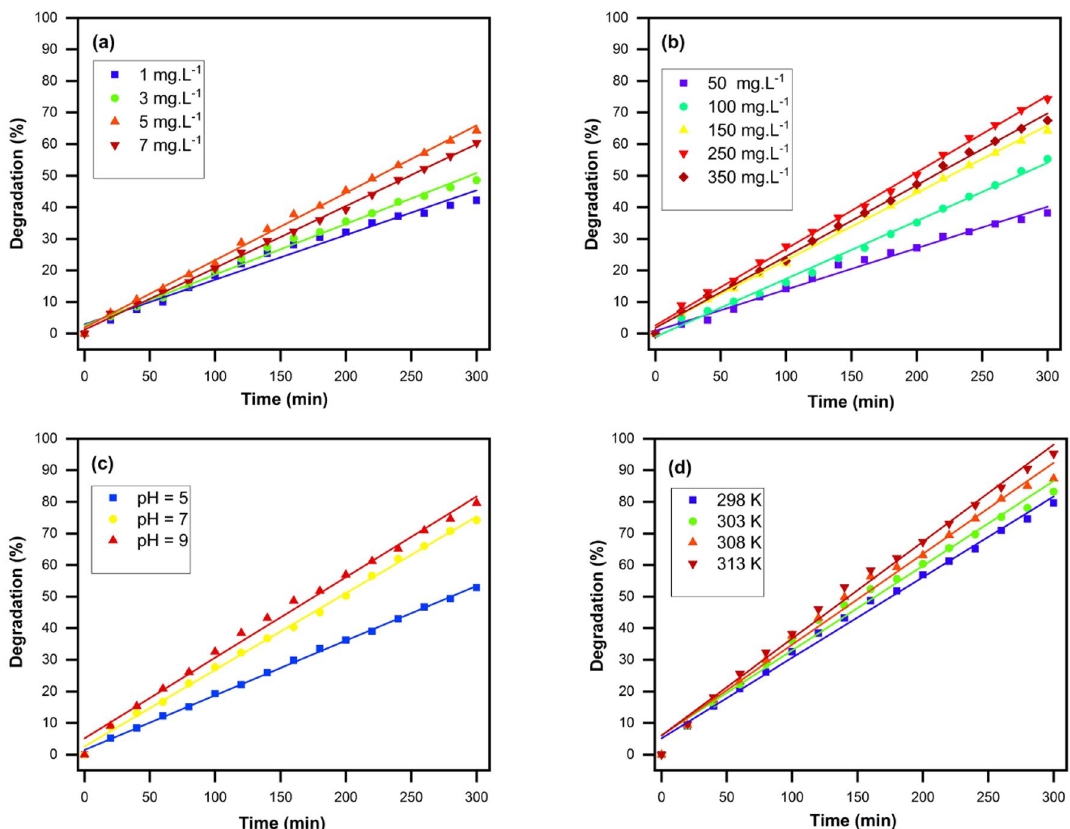
Figure 9. The degradation percentage of MB solution in the presence of ZnO photocatalyst ( a ) with various dye concentrations, ( b ) with different dosage of catalyst, ( c ) with different pH and ( d ) under different